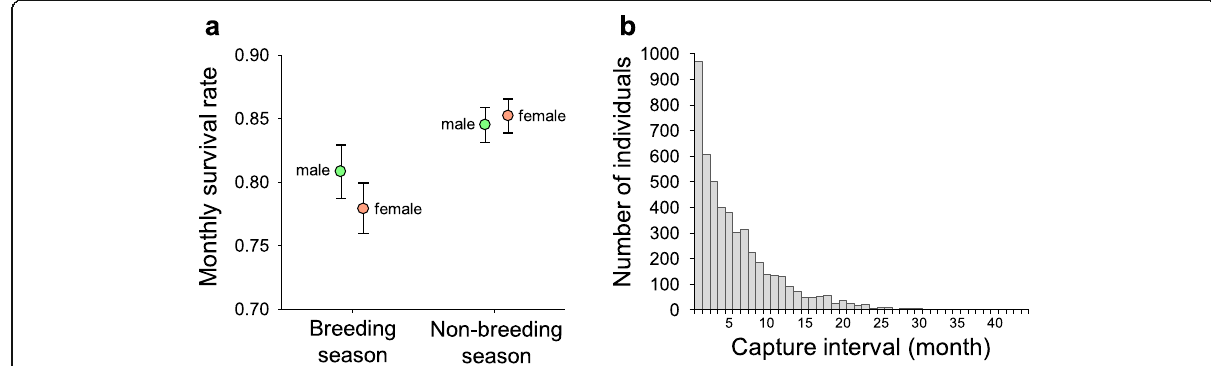
Fig. 6 a Differences of monthly survival rates of males (green) and females (red) in the breeding and non-breeding seasons. Both sexes tend to have lower survival rate in the breeding season ( φ non-breeding female : 0.8526, 0.8236 – 0.8776, φ breeding female : 0.7801, 0.7381 – 0.817; φ non-breeding male : 0.8454, 0.8170 – 0.8701, φ breeding male : 0.8091, 0.7646 – 0.8468). The increased mortality in the breeding season leads to a low survival rate during this period, and the significant decrease in females leads to a male-biased population structure in the non-breeding season. b Statistics of individuals with longest capture intervals. The high mortality rate leads to the short life span of the lizards: among the 4844 lizards ever being recaptured, only 11.44% ( N = 554) survived for more than 12 months, and only 0.91% ( N = 44) survived for more than 24 months. Short life span